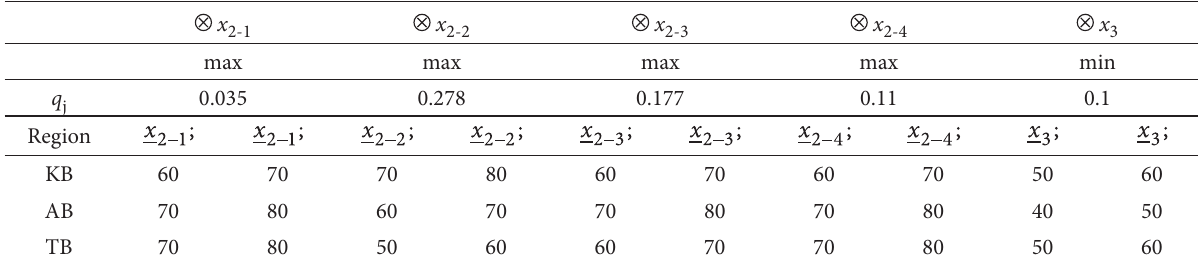
Table 9. (continuation). Initial decision making matrix with the criteria values described in intervals